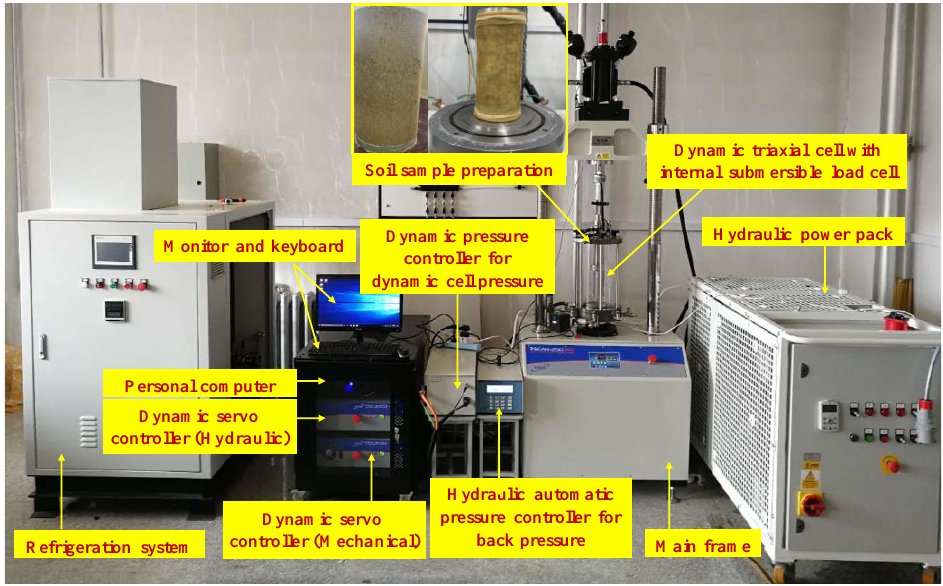
Figure 4. Cryogenic triaxial test system and the tested samples.